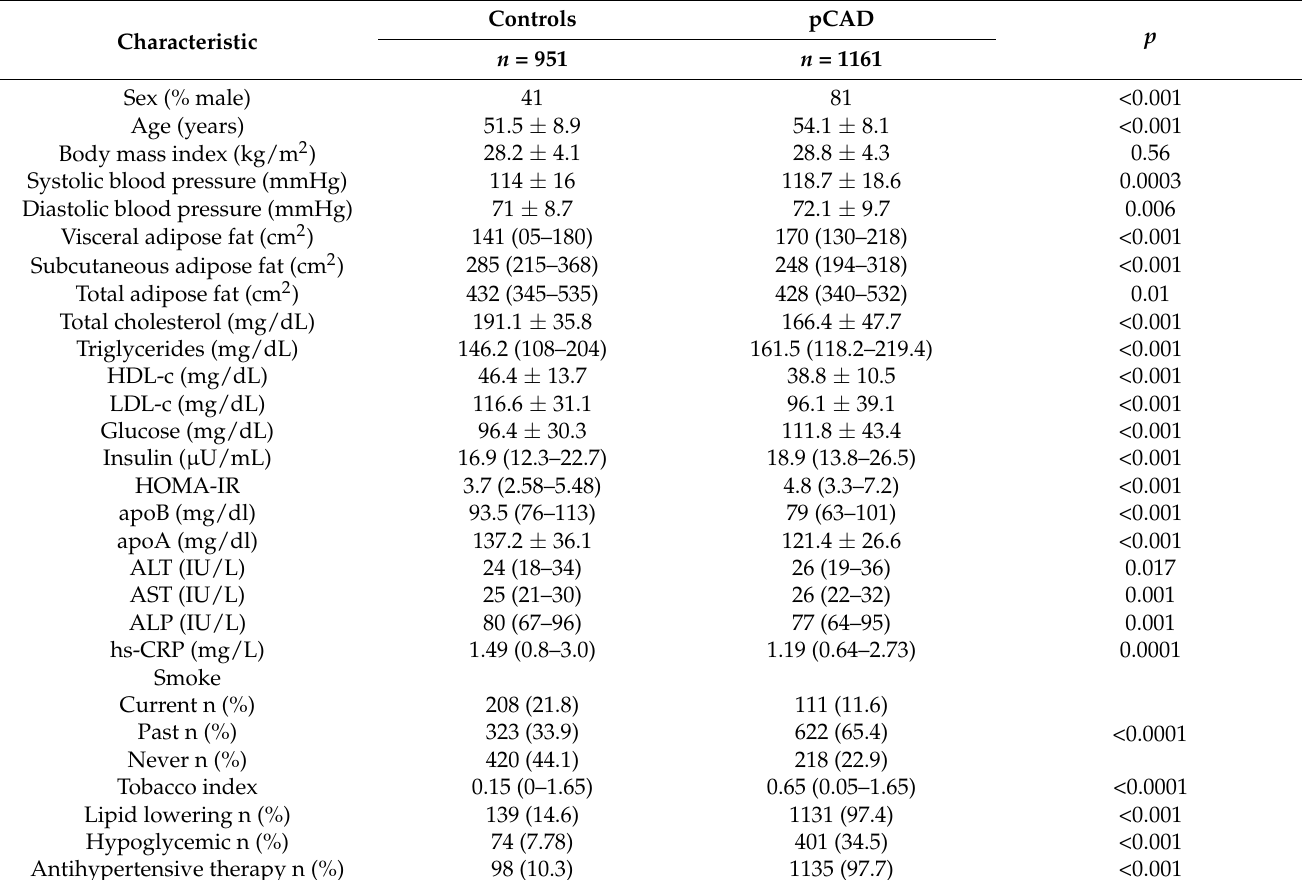
Table 1. Clinical and biochemical characteristics of pCAD patients and healthy controls.